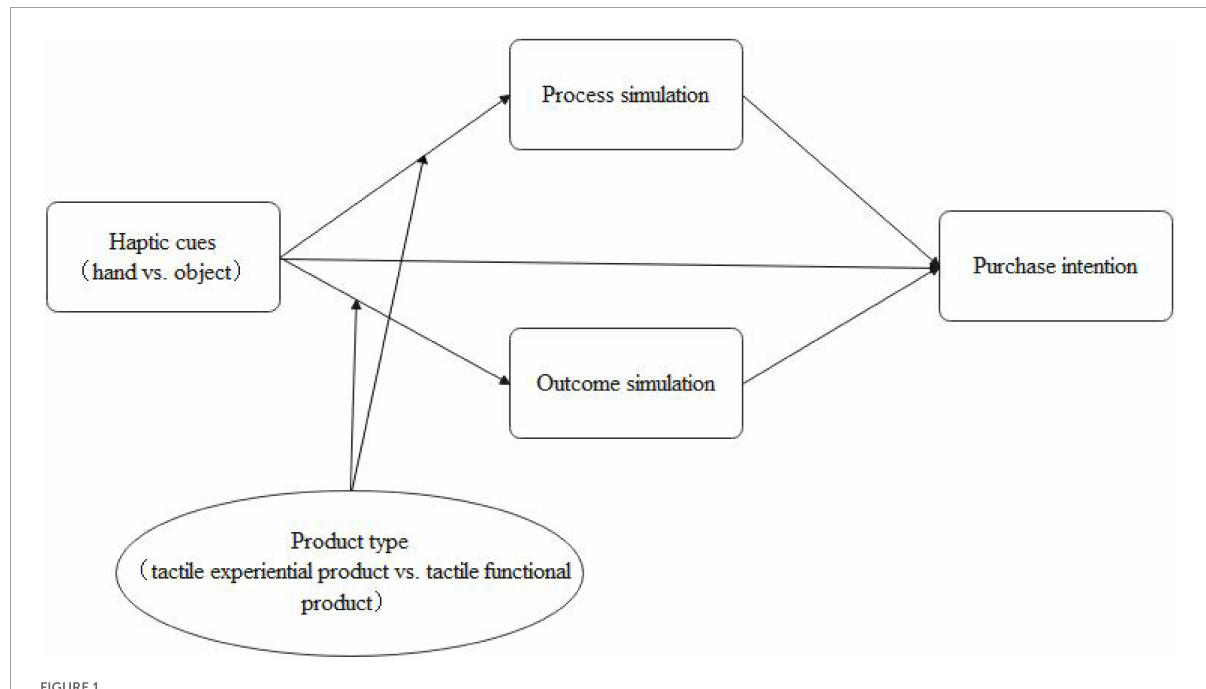
FIGURE1 The theoretical model.